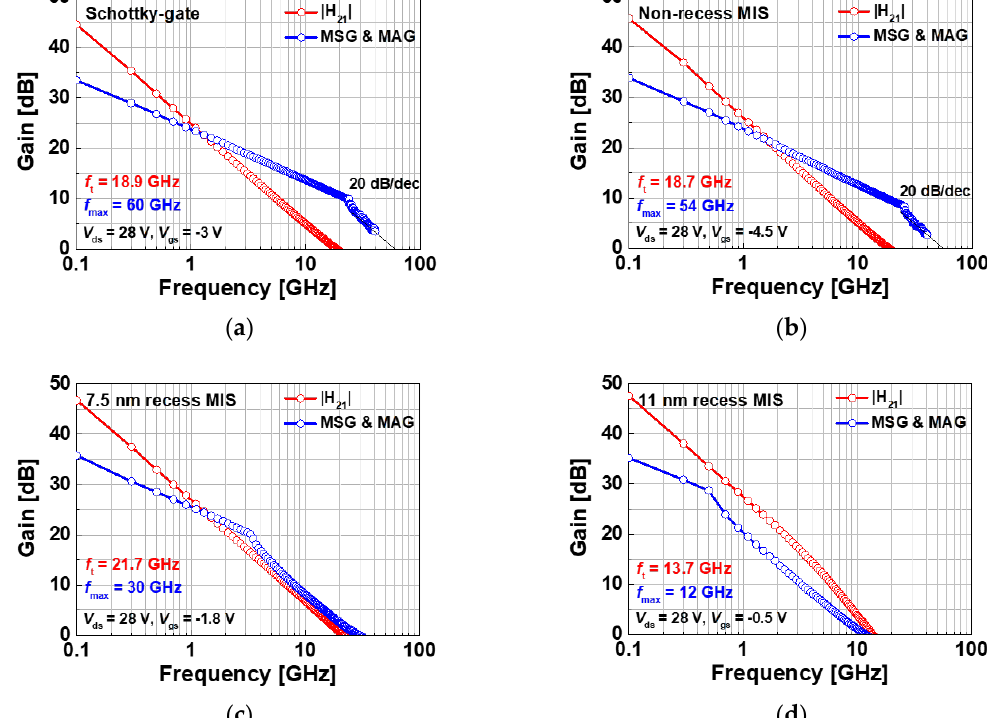
Figure 9. Small-signal characteristics of the fabricated devices; ( a ) Schottky-gate, ( b ) non-recess MIS, ( c ) 7.5 nm recess MIS, and ( d ) 11 nm recess MIS devices.